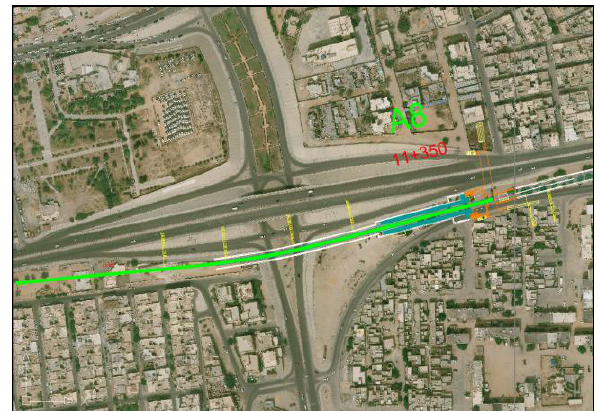
Figure 9. Metro line aligned avoiding a traffic node